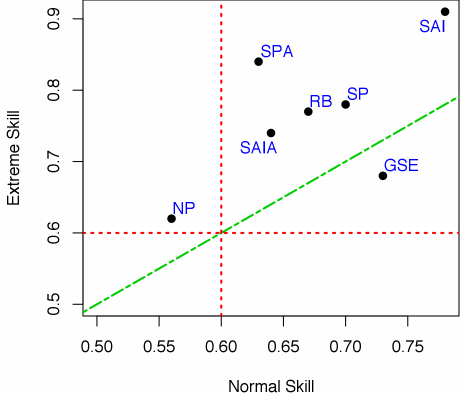
Figure 8. Performance models for normal and extreme conditions. The horizontal axis corresponds to normal skill and the vertical axis to the extreme skill. The green straight dashed line indicates the reference for equal values of the hindcast skill corresponding to anomalous ENSO conditions and those for the ENSO-neutral state. The red dashed straight lines represent an arbitrary threshold for the useful forecast as proposed by Hollingsworth et al. (1980). The acronyms correspond to a model configuration in the different re- gions, as detailed in Table